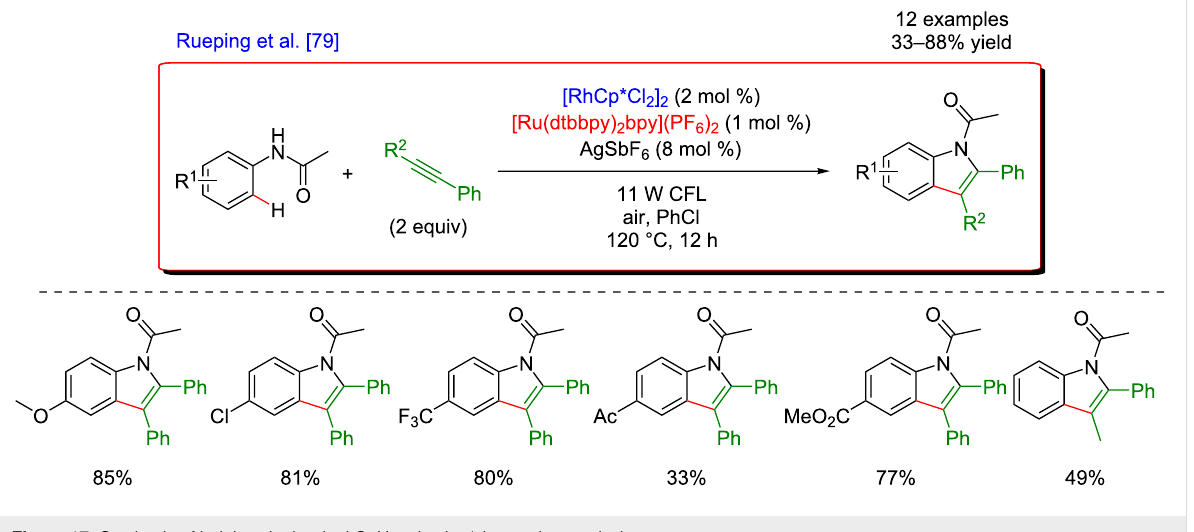
Figure 17: Synthesis of indoles via the dual C–H activation/photoredox catalysis.